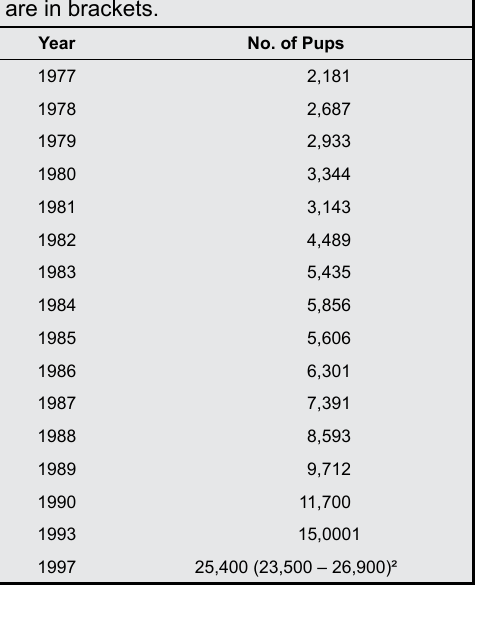
Model estimates